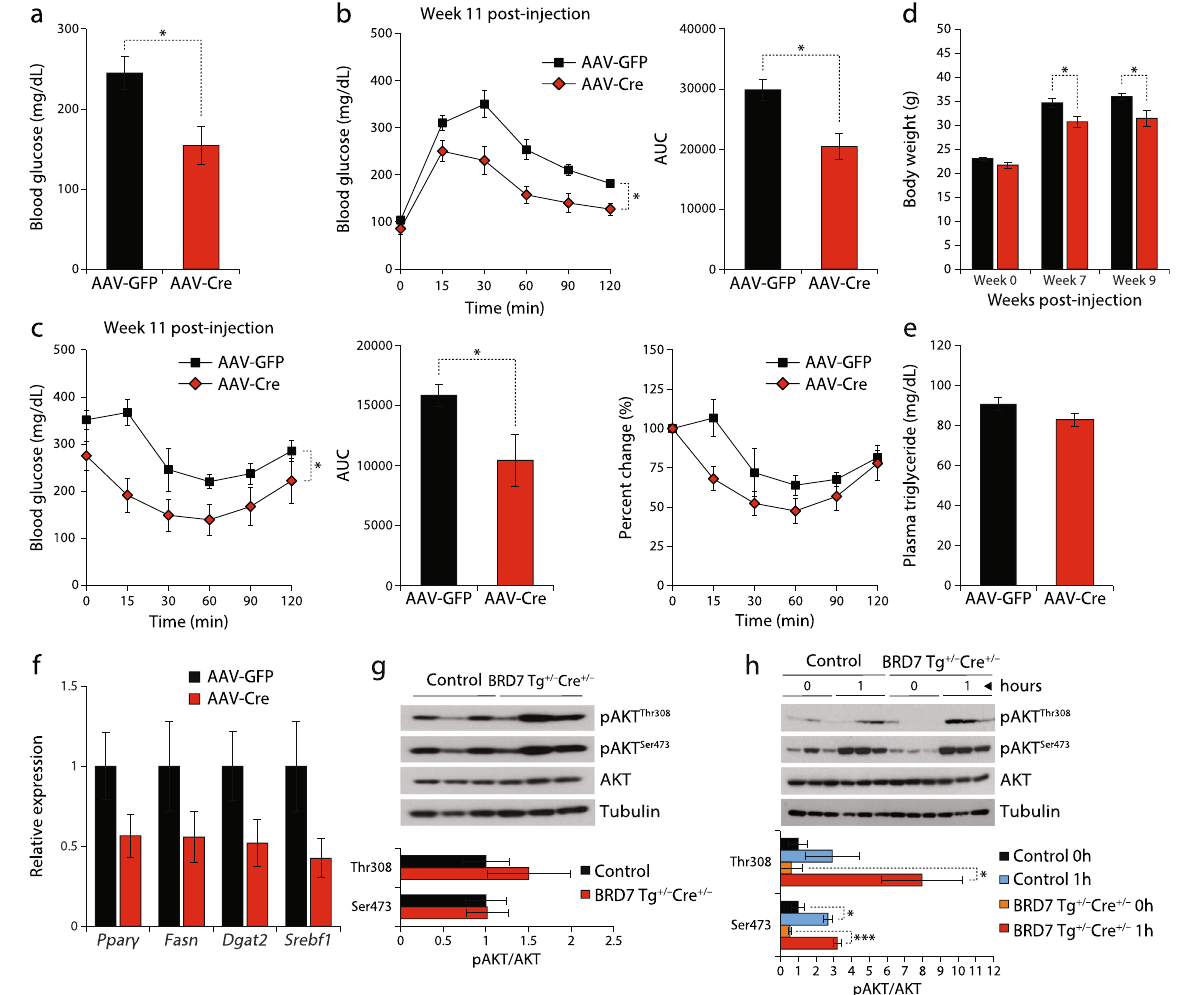
Figure 6. Sustained upregulation of BRD7 leads to long-term improvement in glucose homeostasis. ( a ) Blood glucose levels of HFD-fed male BRD7 Tg + / − mice injected with AAV-GFP or AAV-Cre after 6 hours of fasting on day 12 post-injection (n = 5/group). ( b ) Glucose tolerance test on week 11 post-injection (left). Area under curve (right). ( c ) Insulin tolerance test on week 11 post-injection (left). Area under curve (middle). Percent change of initial blood glucose levels (right). ( d ) Body weights of AAV-GFP and AAV-Cre-injected mice at the time of injection and 7 and 9 weeks post-injection. ( e ) Plasma triglyceride levels 15 weeks post-injection. Mice were fasted for 6 hours. ( f ) Relative mRNA levels of Ppar γ , Fasn , Dgat2 , and Srebf1 normalized to 18 s in the liver of HFD-fed male BRD7 Tg + / − mice injected with AAV-GFP or AAV-Cre at week 11 post-injection. ( g ) Immunoblots of pAKT Thr308 and pAKT Ser473 in the liver of HFD-fed 9-week old male control and BRD7 Tg + / − Cre + / − mice at 6 hours of fasting (top). Quantification of the blots showing normalized ratio between pAKT and AKT (bottom). ( h ) Immunoblots of pAKT Thr308 and pAKT Ser473 in the liver of HFD-fed 14-week old male control and BRD7 Tg + / − Cre + / − mice at 24 hours of fasting and during 1 hour of refeeding following 24 hours of fasting (top). Quantification of the blots showing normalized ratio between pAKT and AKT in the liver of refed mice (bottom). Error bars are represented as mean ± SEM., P values were determined by Student’s t -test. ( * p < 0.05, ** p < 0.01, *** p < 0.001). Significance was determined by two-way analysis of variance (ANOVA) with Bonferroni multiple-comparison